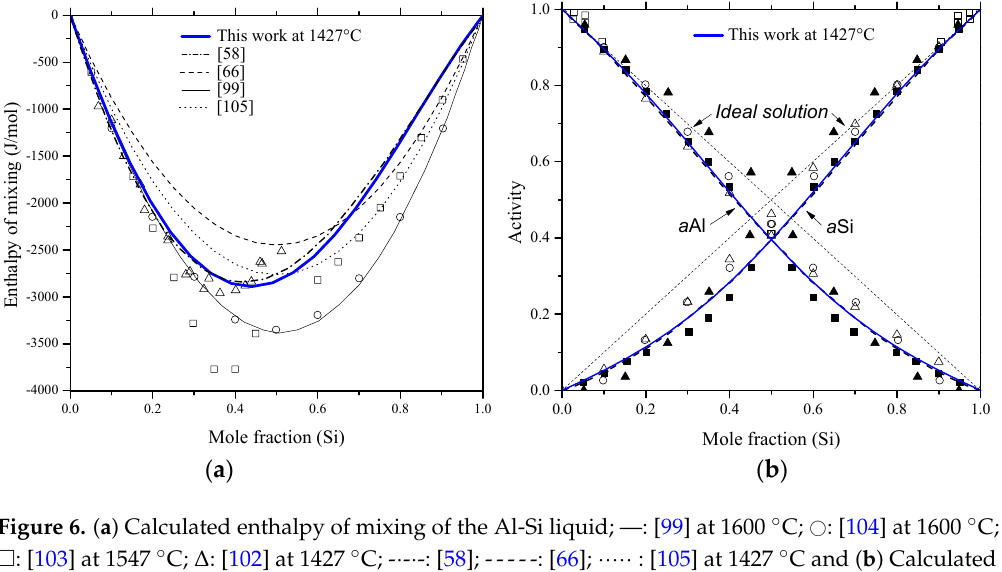
Figure 6. ( a ) Calculated enthalpy of mixing of the Al-Si liquid; ― : [99] at 1600 °C; ○ : [104] at 1600 °C; □ : [103] at 1547 °C; Δ : [102] at 1427 °C; -·-·-: [58]; -----: [66]; ····· : [105] at 1427 °C and ( b ) Calculated activity of Al and Si in the Al-Si liquid at 1427 °C; -----: [99] at 1600 °C; ○ : [106]; □ : [107] and Δ : [100] at 1427 °C; ■ : [103] at 1547 °C; ▲ : [108] at 1700 °C. Table 4. Optimized model parameters of the Al-Si system. Phase Excess Gibbs Energy Parameter (J/Mole) Ref.